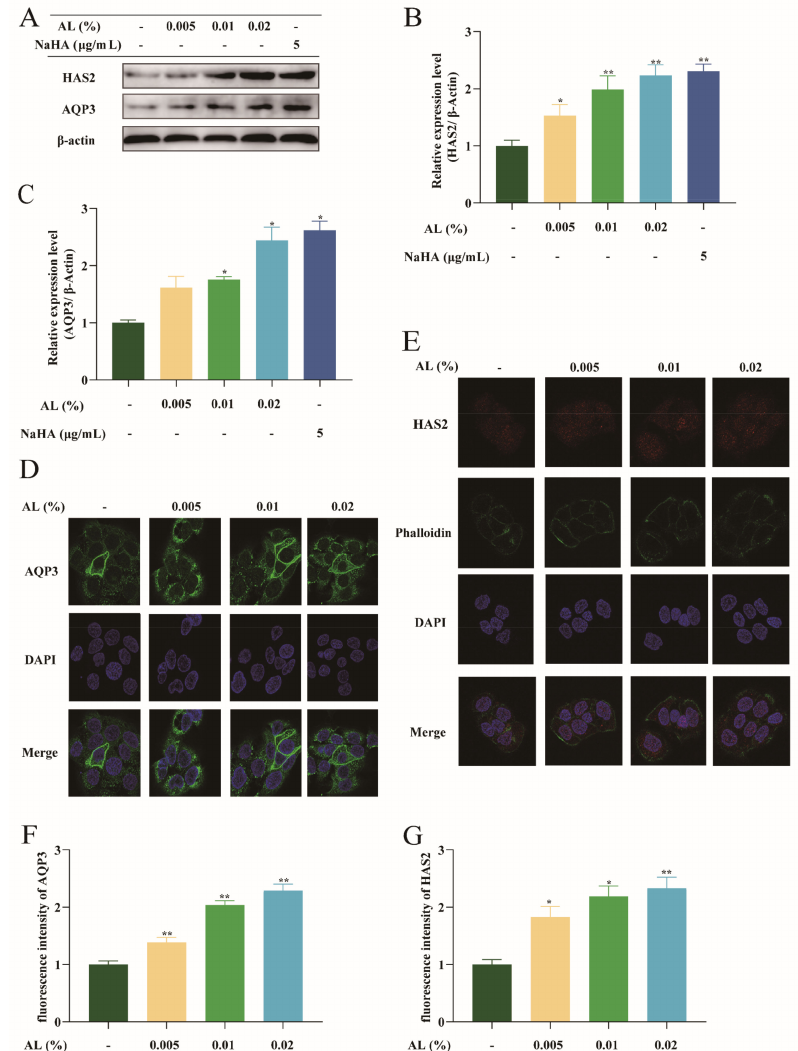
Figure 3. AL activated AQP3 and HAS2 in HaCaT cells. ( A ) Protein bands of AQP3 and HAS2 via Western blotting; ImageJ software protein quantification assay of HAS2 ( B ); AQP3 ( C ) protein expression levels of HAS2 using ImageJ software; ( D ) IF staining of AQP3 in HaCaT cells (63 × ) and ( F ) its protein quantification analysis; ( E ) IF staining of HAS2 in HaCaT cells (63 × ) and its protein quantification analysis ( G ). The target protein’s quantitative result is the gray value of the β -actin. Results are expressed as means ± SDs of three independent experiments. ** p < 0.01, * p < 0.05 compared to the normal group (no treatment). Significance was measured using a one-way